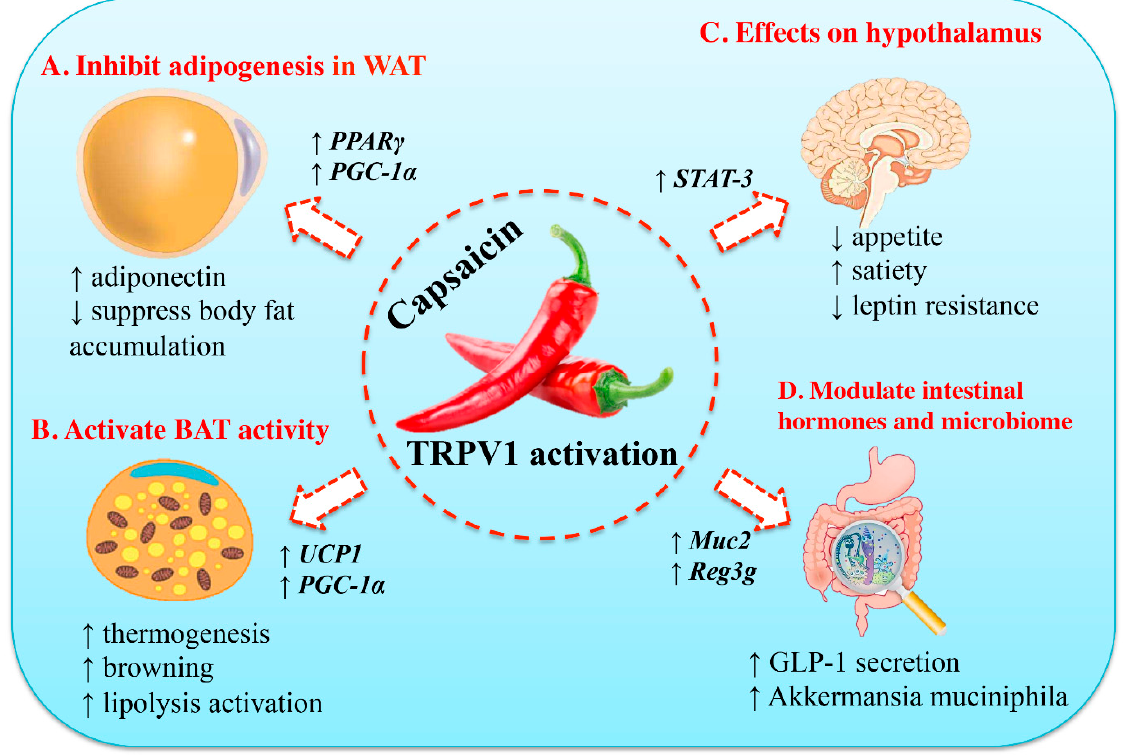
Figure 2. Molecular mechanisms of the anti-obesity effects of capsaicin. ( A ) Capsaicin can inhibit adipogenesis in preadipocyte and adipocyte by up-regulating the expression of peroxisome prolif- erator-activated receptor gamma (PPAR γ ) and uncoupling protein-1 (UCP-1). Thus, it will stimulate adiponectin secretion and increase body fat accumulation. ( B ) Capsaicin can activate brown adipose tissue (BAT) activity, accompanied by increased expression of UCP-1 and PPAR-coactivator-1 α (PGC-1 α ). ( C ) Capsaicin can suppress appetite, increase satiety, and ameliorate insulin resistance. ( D ) Capsaicin can modulate its function in the gastrointestinal tract and gut microbiome, including stimulation of glucagon-like peptide-1 (GLP-1) secretion and increase in population of the gut bac- terium Akkermansia muciniphila . STAT-3, and signal transducer and activator of transcription-3 (STAT3). Reproduced with permission from [66].